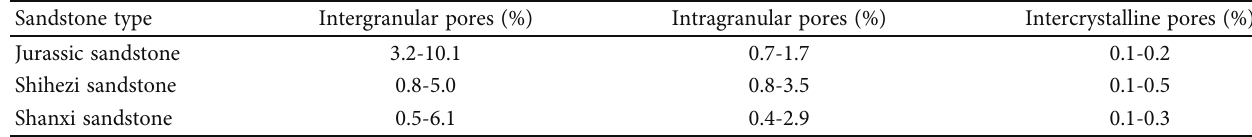
Table 2: Contents of the three main pore types in deep mine sandstone ∗ .